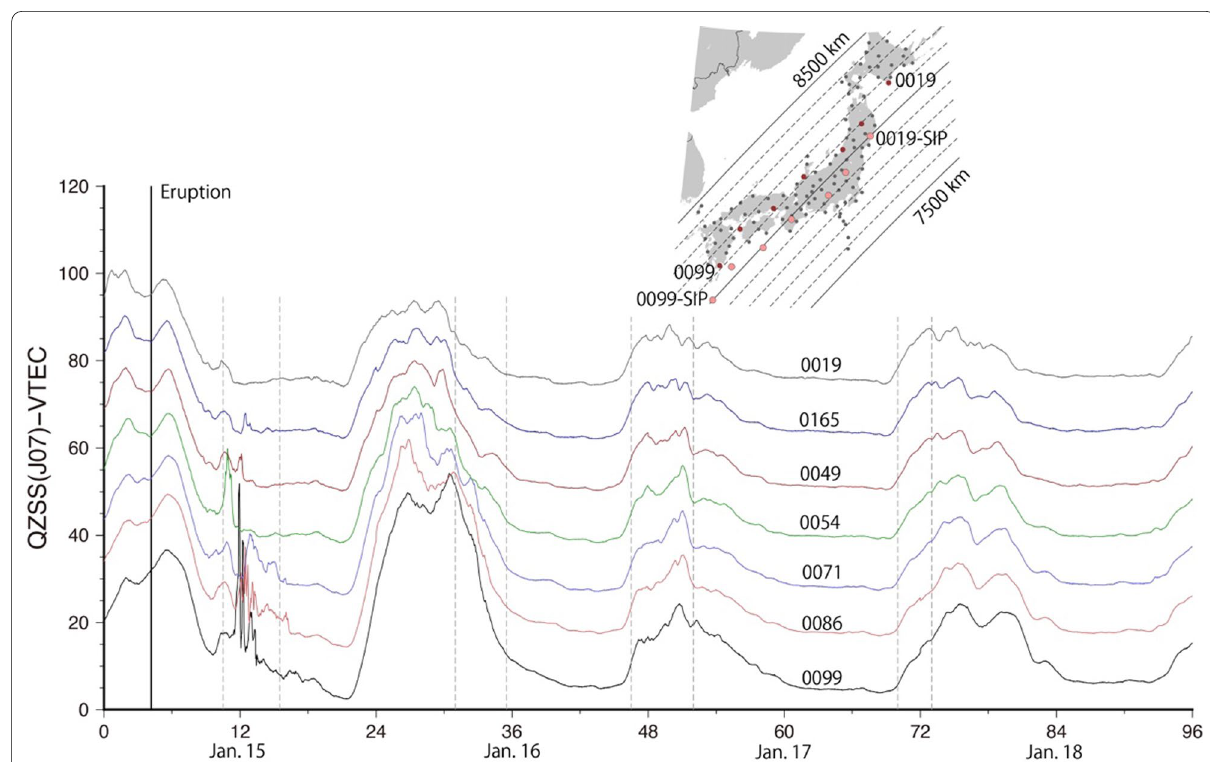
Fig. 5 VTEC time series at 7 GNSS stations, whose SIPs located along the small circle with the distance ~ 8000 km from the Hunga Tonga-Hunga-Ha’apai volcano. Shapes of the peaks associated with the first passage are diverse, e.g., one small/simple peak at 0019, two peaks at 0165/0049, and strong/complicated peaks at 0099. See Fig. 4 caption for details. The VTEC changes during the first LW passage ( t magnified in Additional file 1: Fig.